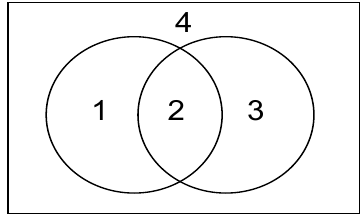
Figure 4. Partial